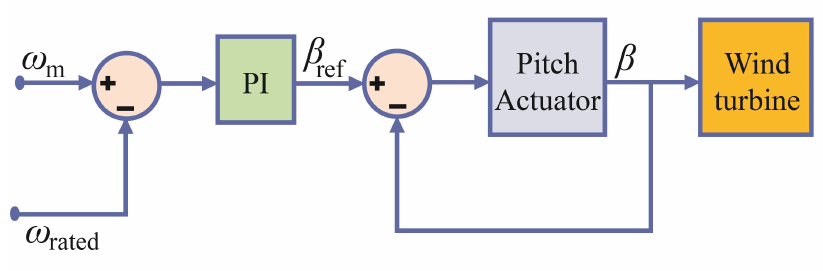
Figure 7. Pitch angle controller design for